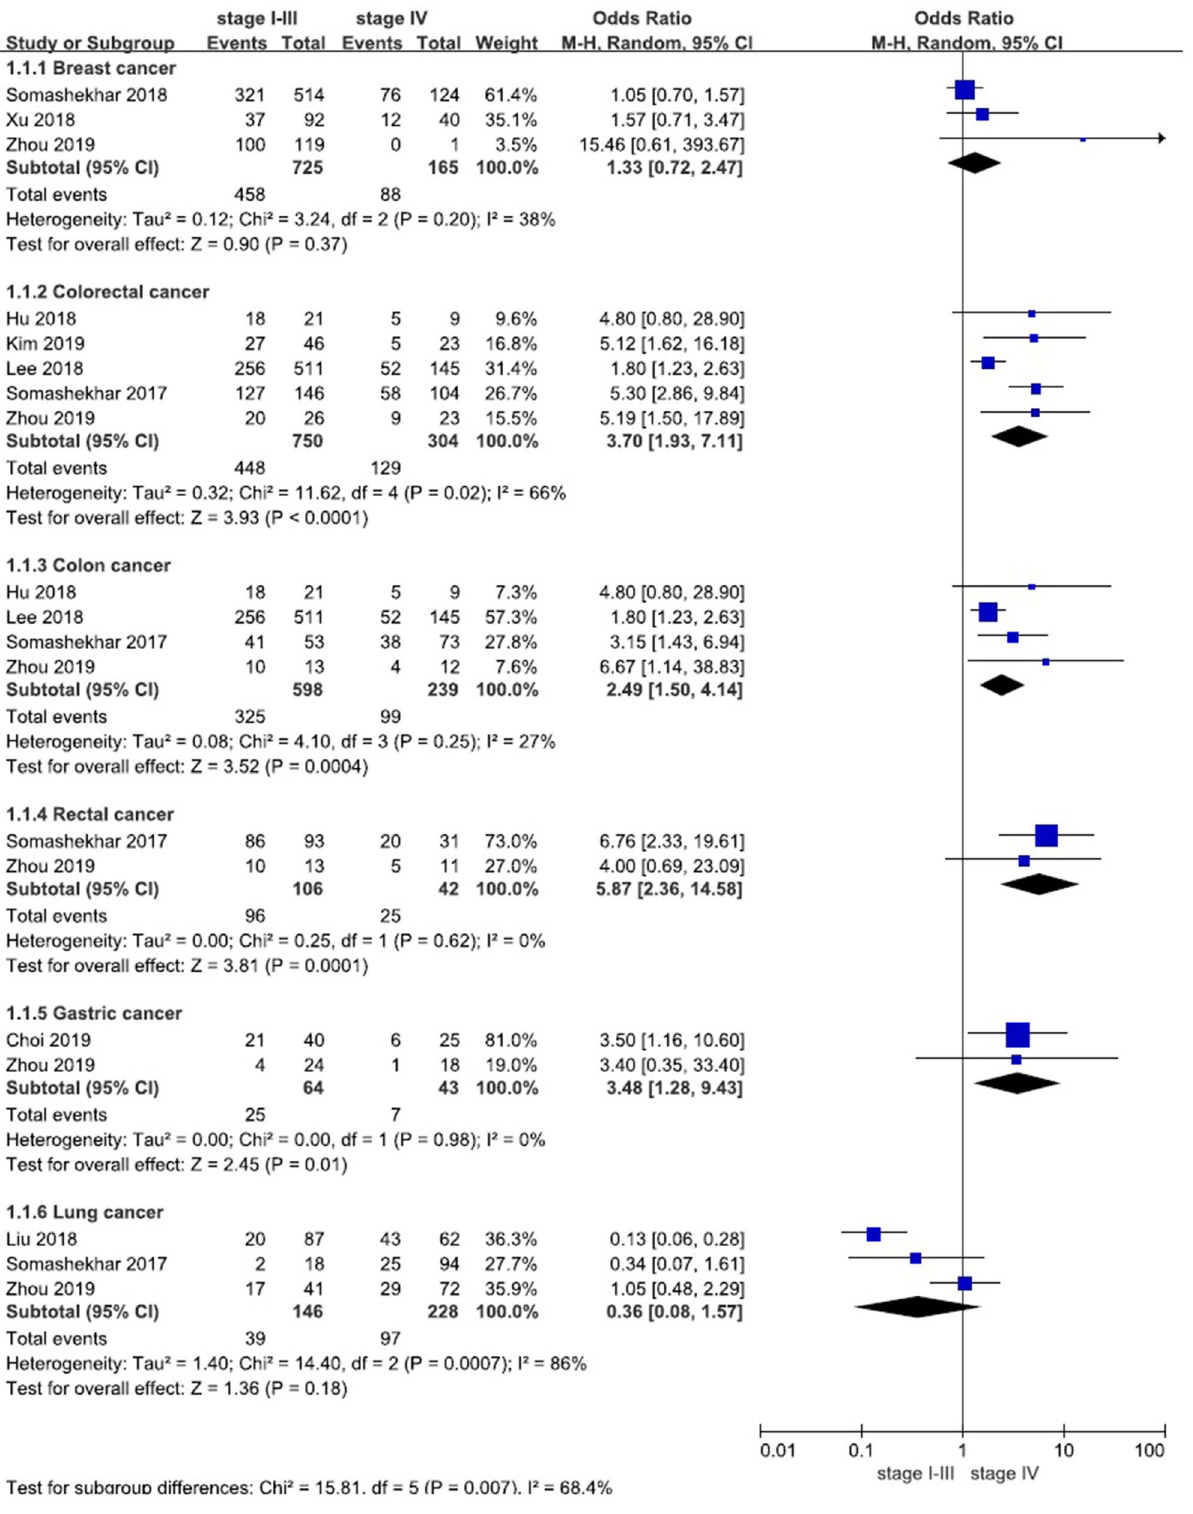
Figure 5. Forest plot of consistency between WFO (only ‘Recommended’) and MDT for patients with various cancers in stages I–III and IV